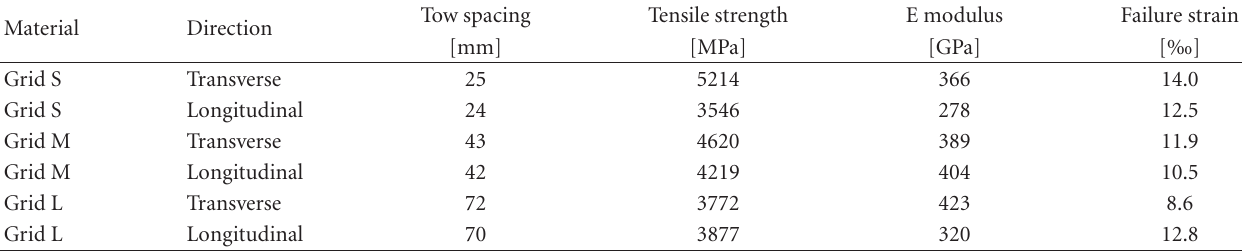
Table 1: Mechanical properties for the fibres in each tow of the CFRP grids used in experimental tests [53]. Material